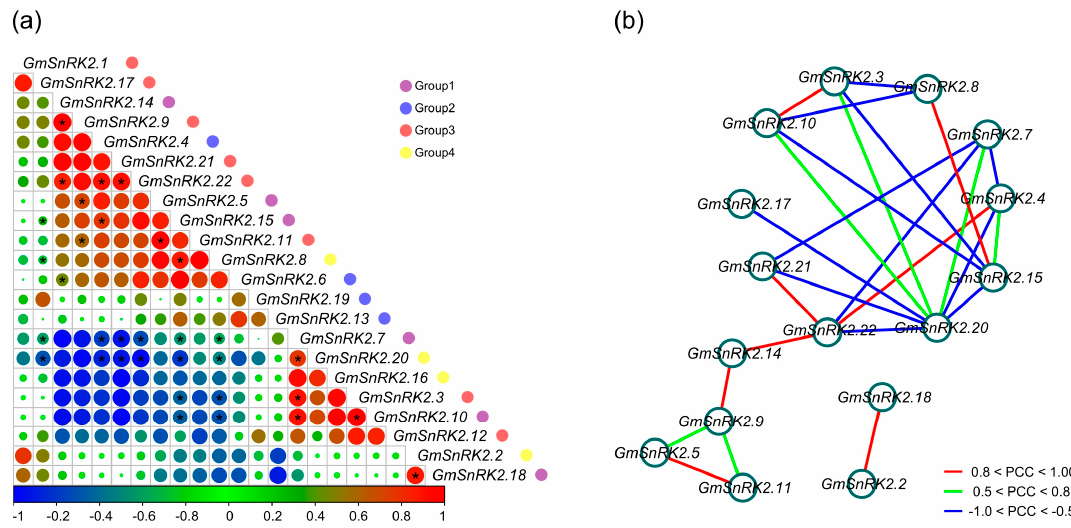
Figure 5. Correlations and co-regulatory networks of GmSnRK2 genes during seed development. ( a ) Correlation analysis of GmSnRK2 genes during seed development were performed based on the Pearson correlation coefficients (PCCs) of gene pairs calculated using R package program (version 3.2.2; available online: https://cran.r-project.org/web/packages/pheatmap/). Correlations are indicated by the size and color of circles. Below bar represents the correlation values of Pearson correlation coefficients (PCCs). Red and blue colors indicate positive correlation and negative correlation, respectively. Gene names are listed at the right. Group 1, Group 2, Group 3 and Group 4 are marked as purple, blue, red, and yellow circles, respectively. Black star represents the correlation with p -value ≤ 0.05; ( b ) co-regulatory network of GmSnRK2s during seed development was illustrated by Cytoscape (version 3.1, Seattle, WA, USA). The significant PCCs of gene pairs ( p -value ≤ 0.05) are included, and the different correlation levels of gene pairs are marked by edge lines with different colors, as showed below the co-regulatory networks.